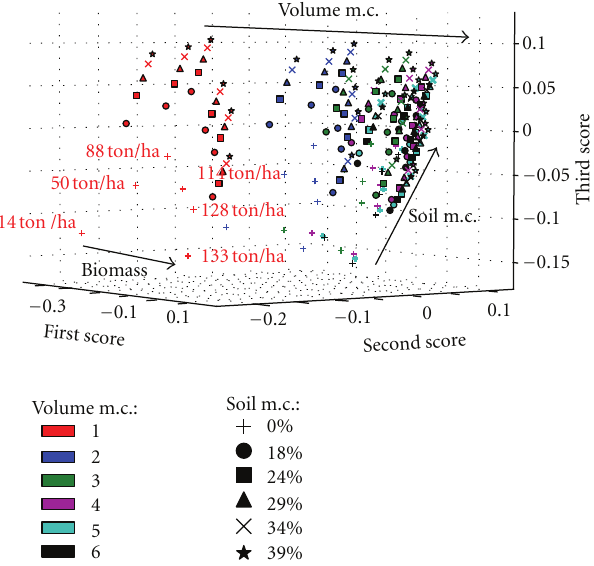
Figure 13: Result of a PCA on radar HH, HV, VV radiometry and optical NDVI, GVMI, and NINSOL indexes, for forests with